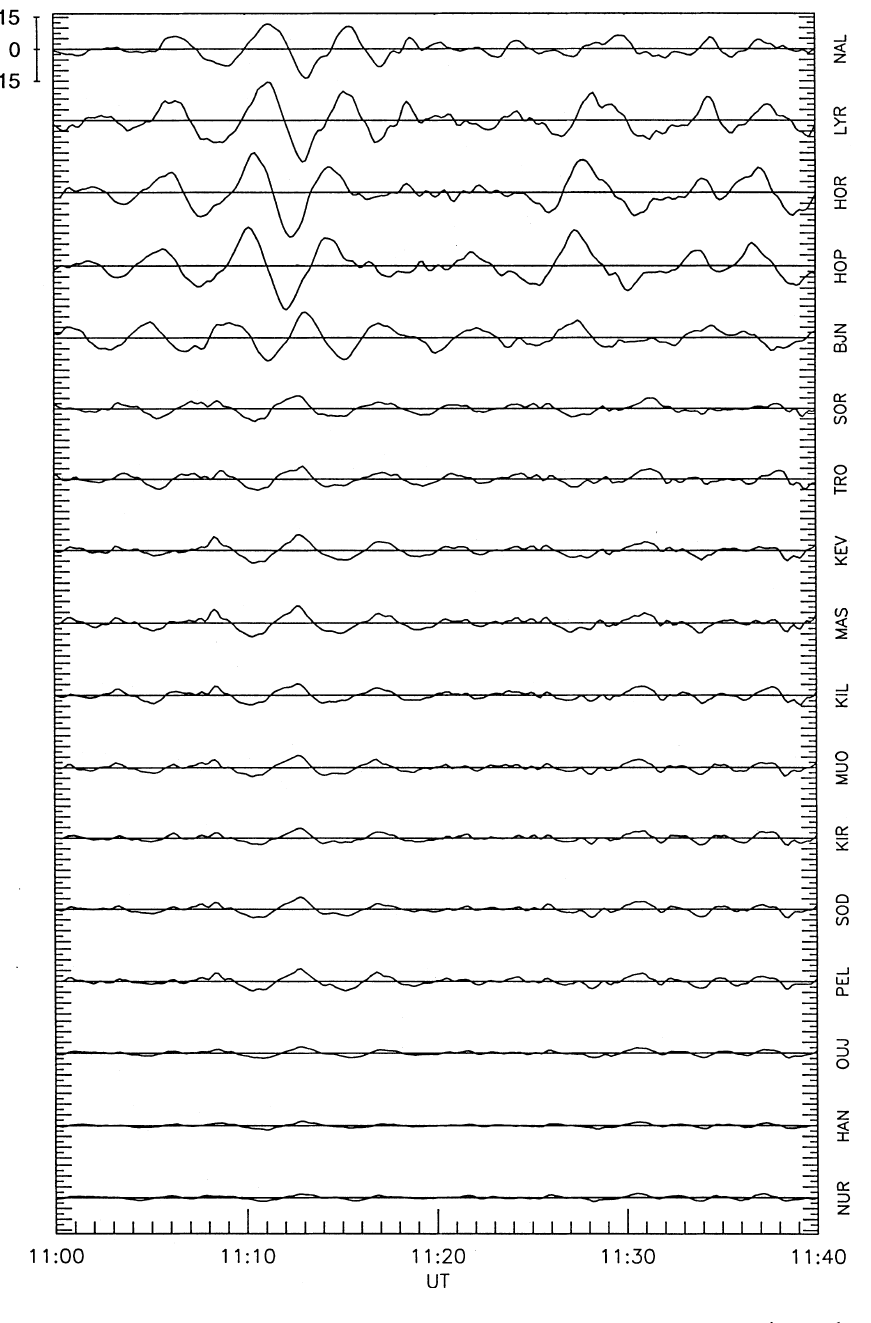
Fig. 5. X-component magnetometer data from 17 ground stations in the IMAGE network. Station geomag- netic latitudes range from 56 (cid:176) N (NUR) to 76 (cid:176) N (NAL). All data have been filtered to exclude periods out- side the range